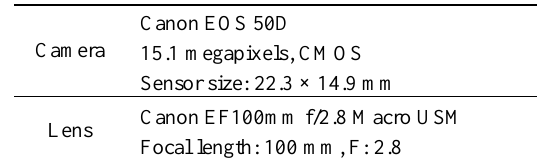
Table 1. Specifications of camera and